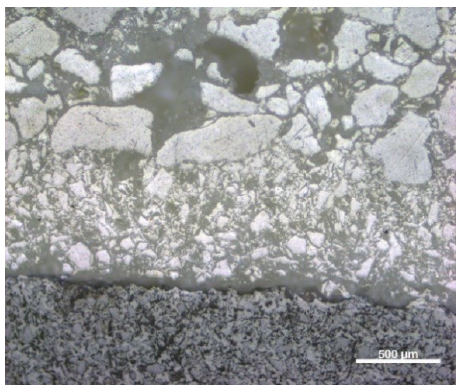
Figure 8. Microstructure of fracture: sample Q1, heated at 950 °C (light microscopy).